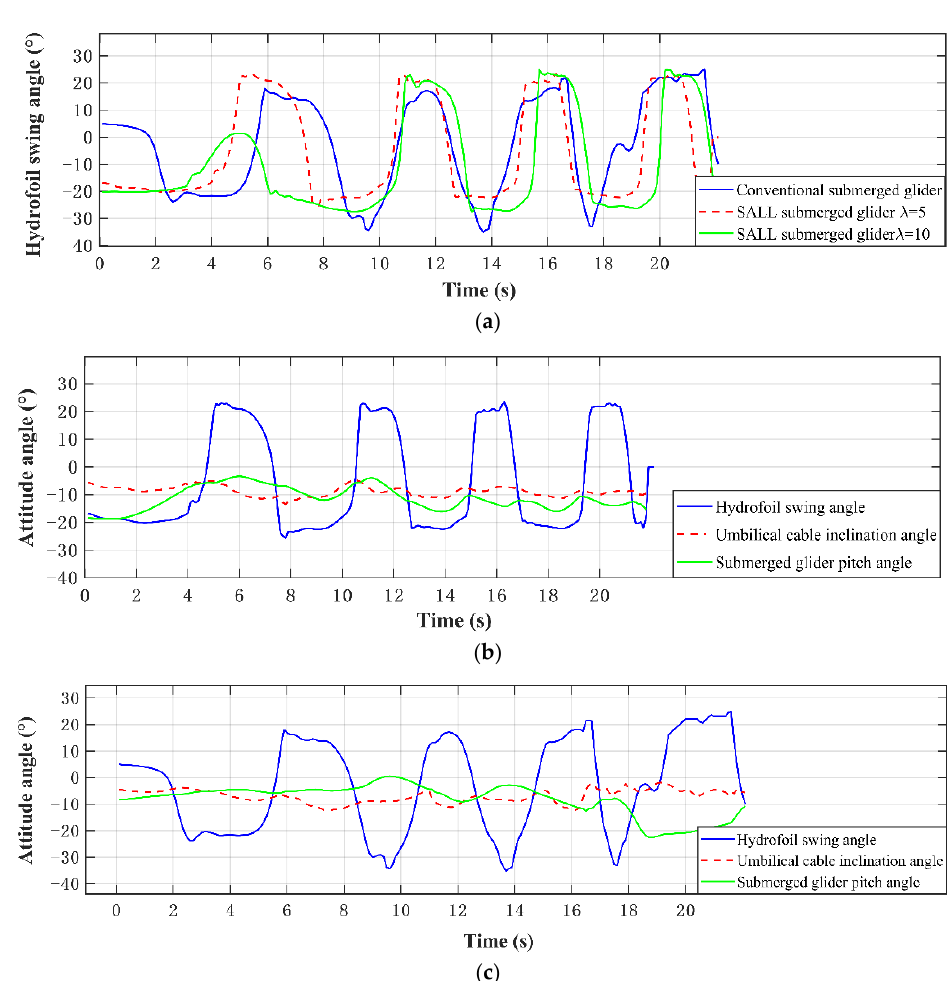
Figure 25. Tank experiments under the conventional submerged glider and the SALL submerged glider. ( a ) The swing angle comparisons of the conventional and the SALL submerged gliders; ( b ) the attitude angle of the SALL submerged glider; and ( c ) the attitude angle of the conventional submerged glider.